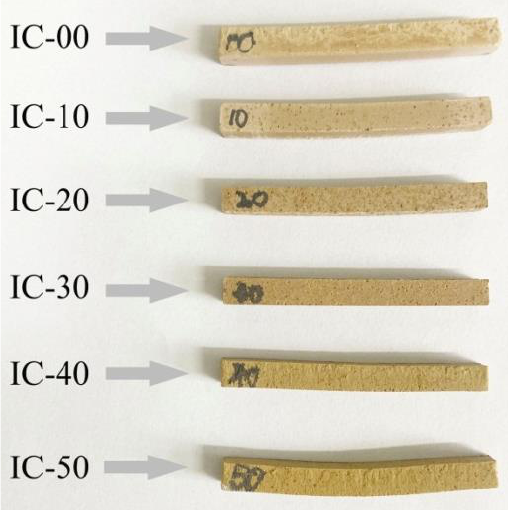
Figure 7. Photos of pyroplastic deformation state of the ceramic samples.